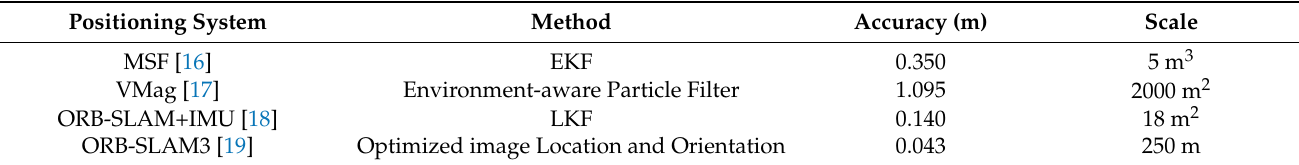
Table 2. Technical comparison of coupling systems.